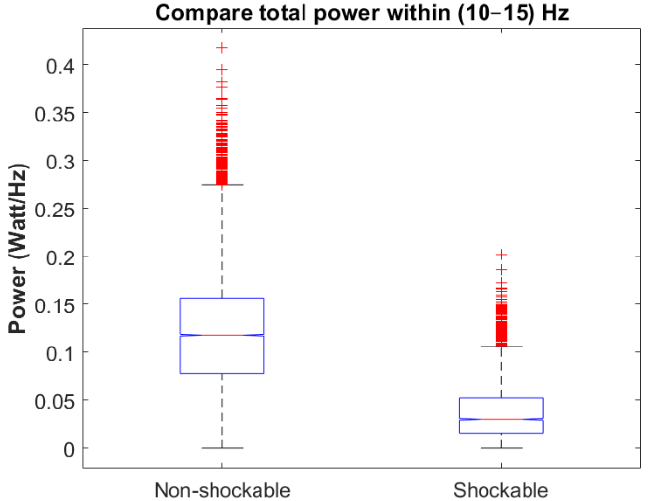
Table 2. Estimated power (watt/Hz) in the development samples for frequencies within (10–15) Hz.